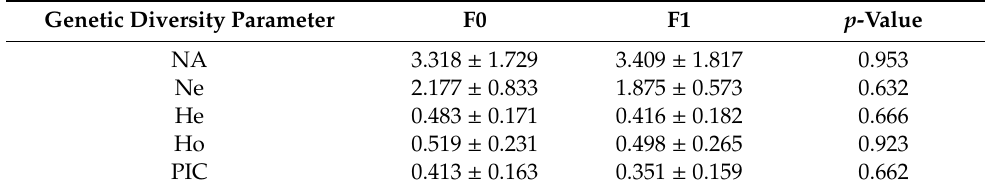
Table 5. Genetic diversity analysis of two generations of New Zealand white rabbit with the 22 optimal SSR